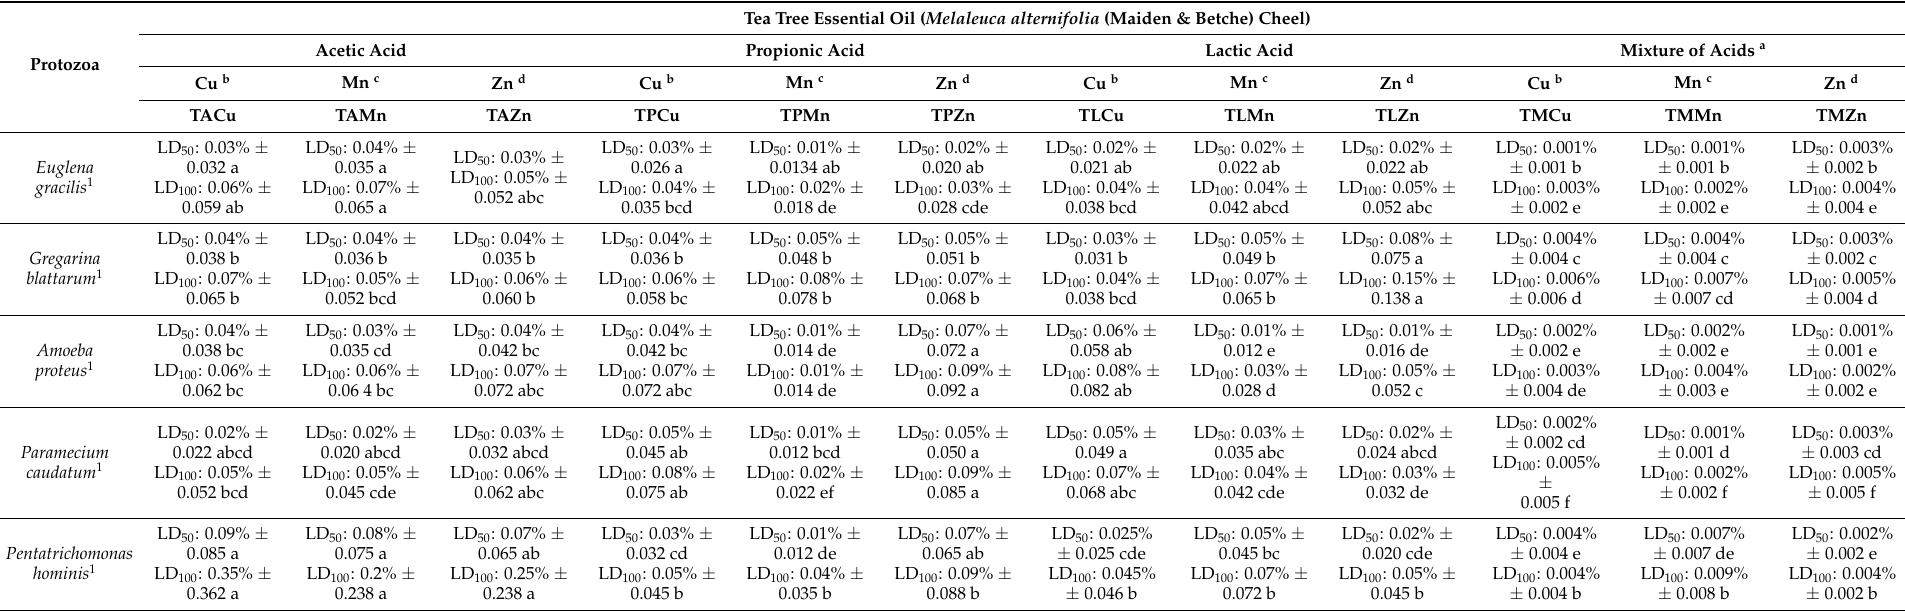
Table 5. LD 50 , LD 100 values of tea tree essential oil ( Melaleuca alternifolia (Maiden & Betche) Cheel) (T), organic acids (Acetic acid—A, Propionic acid—P, Lactic acid—L, Mixture of acids—M) and metal ion against selected protozoa. Tea Tree Essential Oil ( Melaleuca alternifolia (Maiden & Betche) Cheel) Propionic Acid Lactic Acid Mixture of Acids